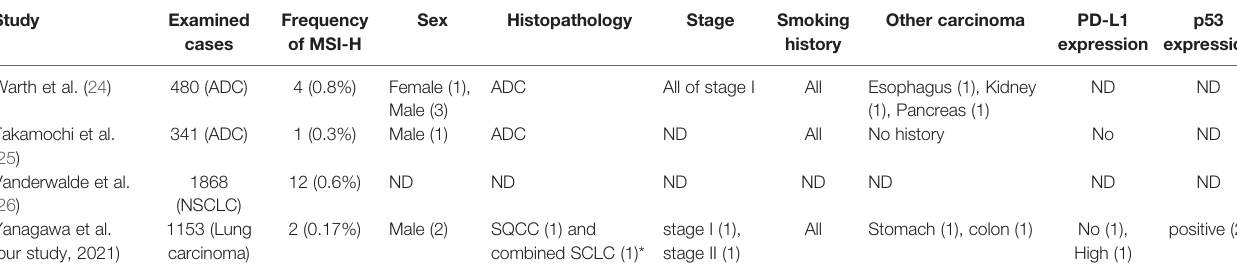
TABLE 2 | Large-scale studies about MMR de fi ciency in Lung